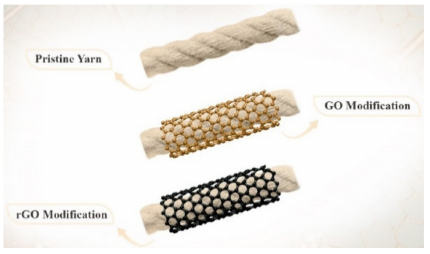
Figure 7. Images of the pristine, GO-modified, and rGO-modified CGYs